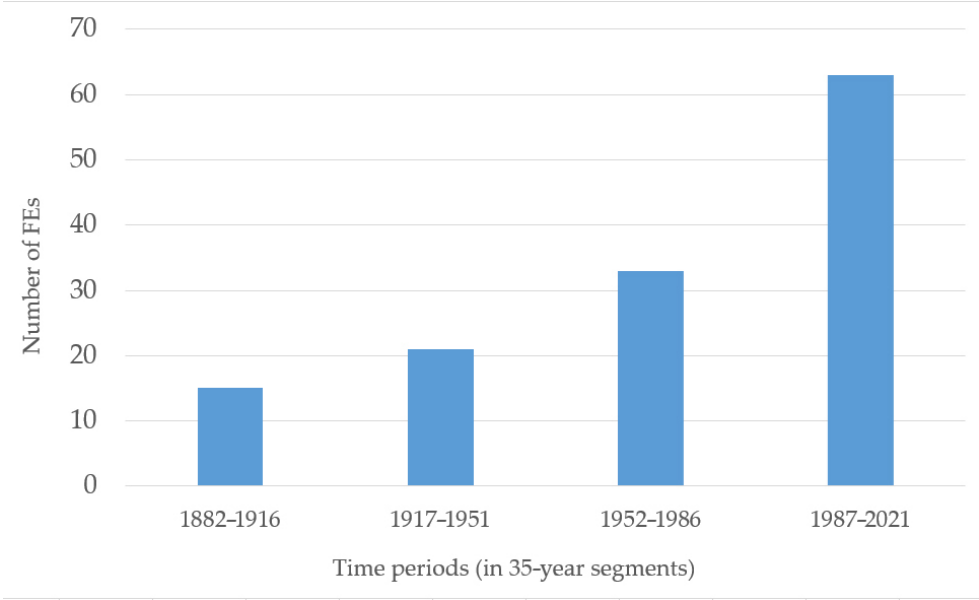
Figure 11. Graph showing the number of flood events (FEs) in four 35-year segments of the study period (1882–2021).